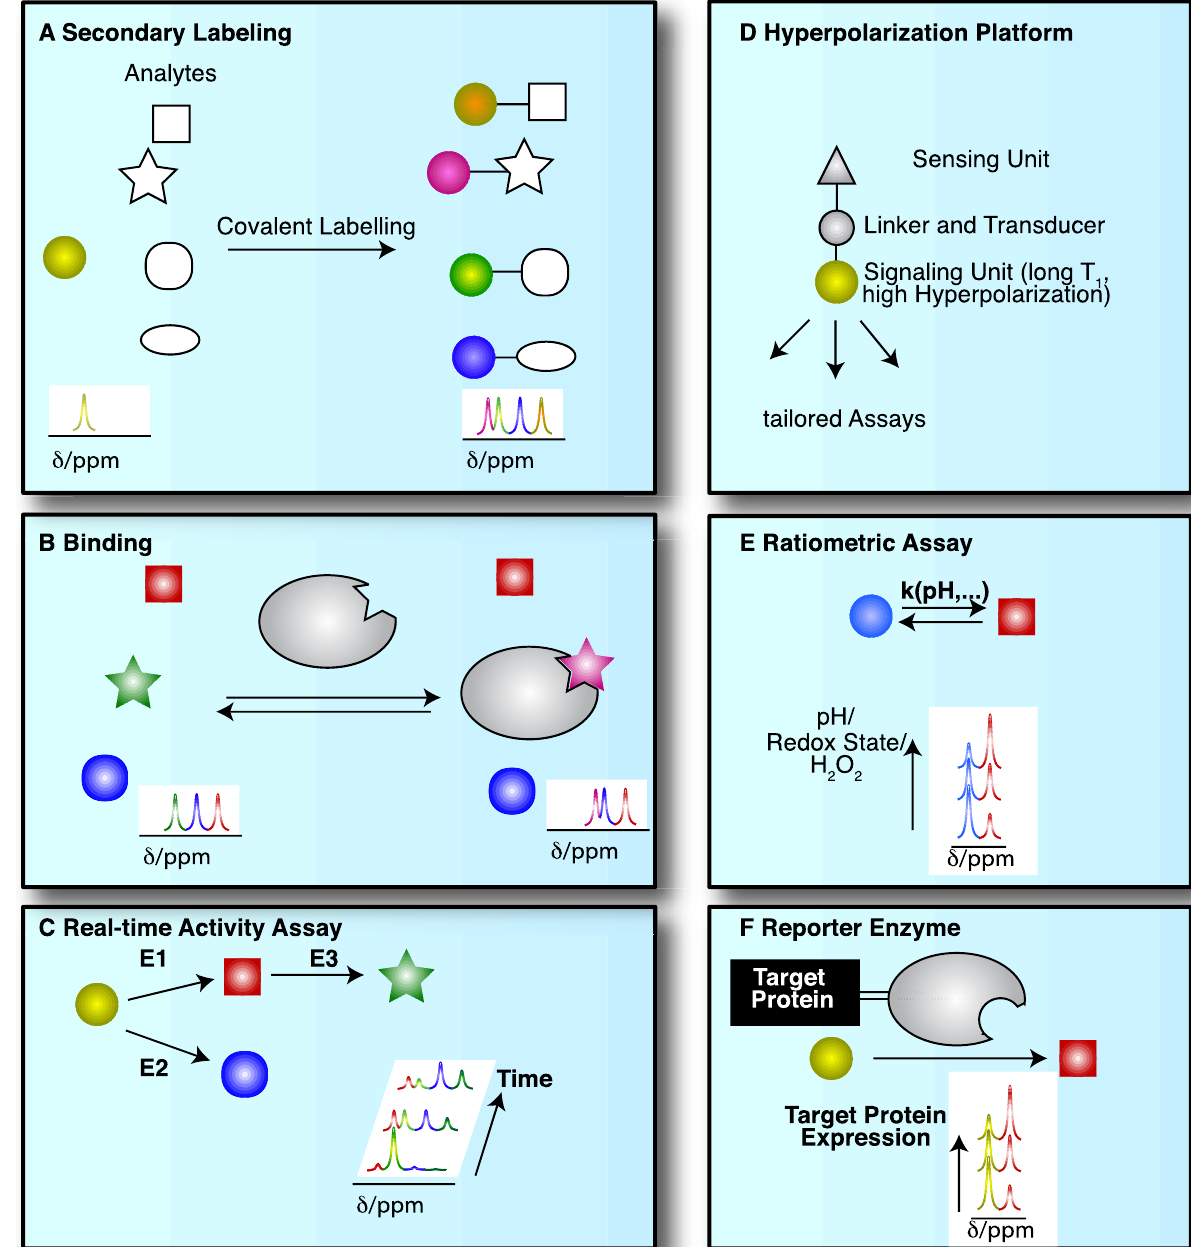
Figure 3. Schematics of different strategies for the use of hyperpolarized labels and probes for NMR spectroscopic biological assays: Hyperpolarized molecules have been used for ( A ) readout by covalent chemical labeling of analytes; ( B ) probing of non-covalent binding; ( C ) the tracking of enzymatic transformations; ( D ) the design of versatile probe platforms; ( E ) ratiometric measurements of physicochemical states and ( F ) interrogating protein expression by probing attached reporter